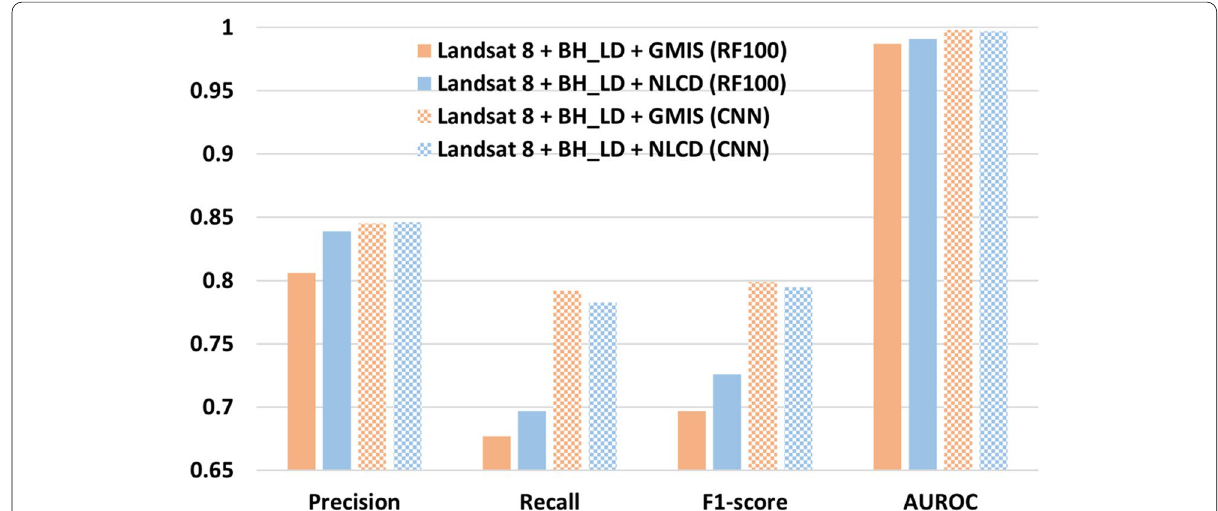
Fig. 16 The macro indices (precision, recall, F1‑score, and AUROC) for different imperviousness datasets, GMIS (orange) and NLCD (blue) using RF100 (solid fill) and CNN (checked fill)